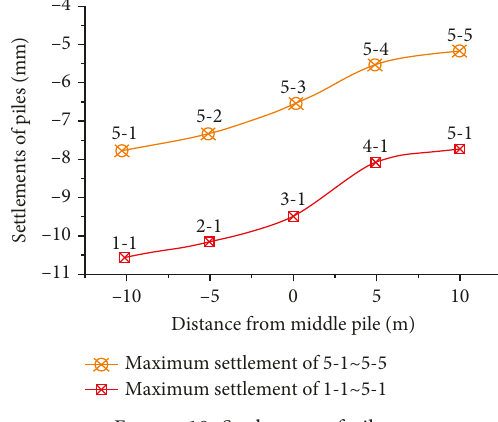
Figure 18: Settlement of piles.